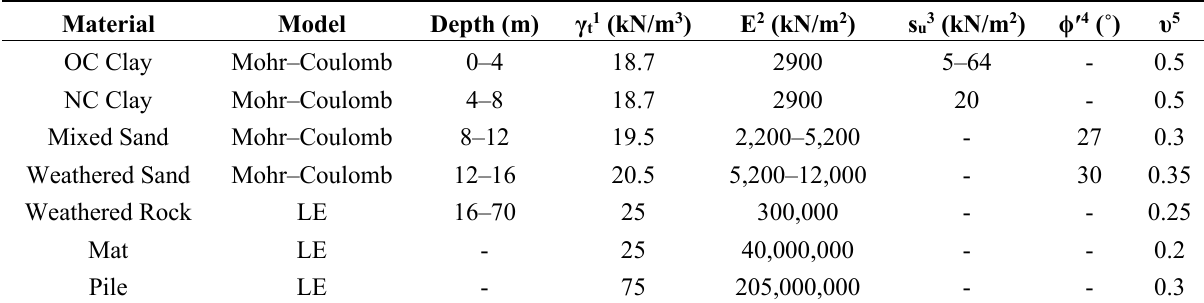
Table 2. Material properties for the prototype model load